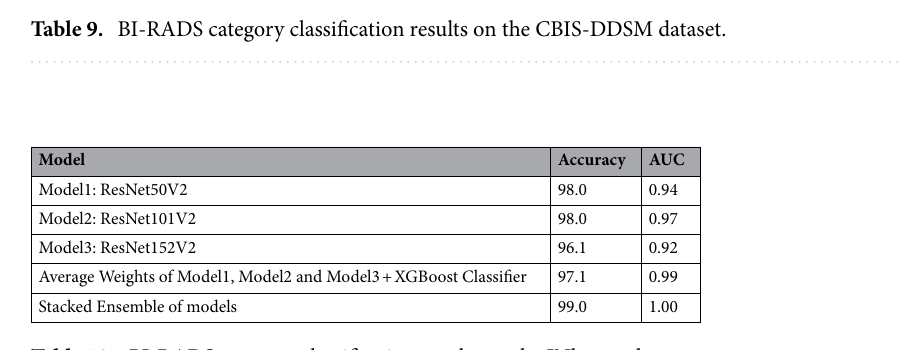
Table 10. BI-RADS category classification results on the INbreast dataset.